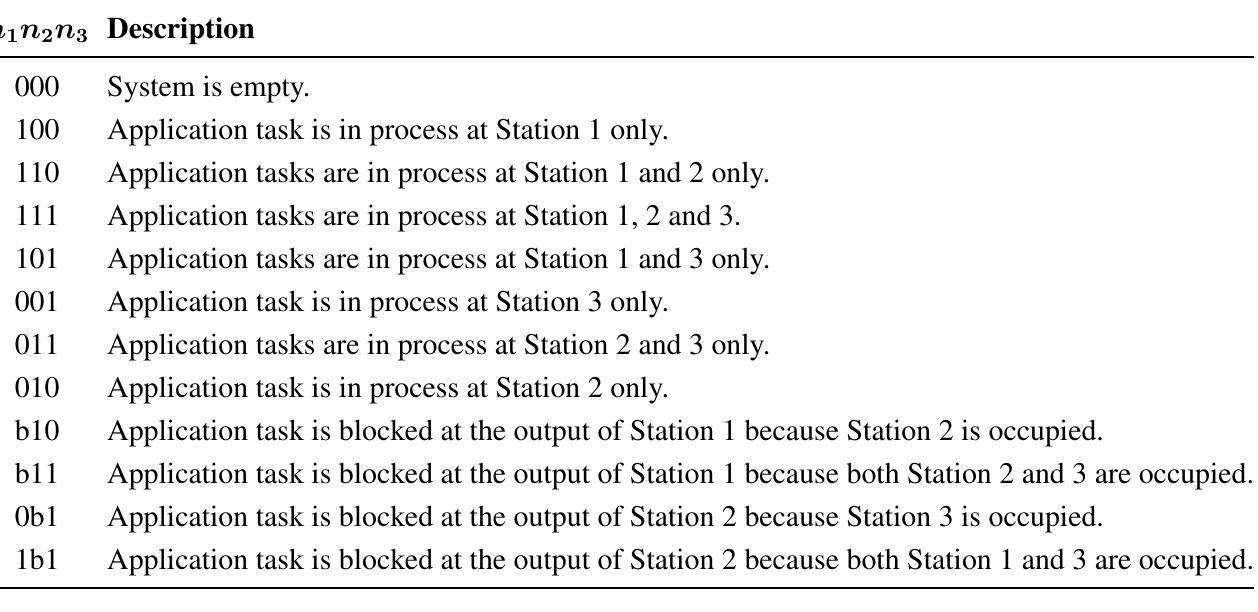
Table 1. Steady State Status during Tasks Processing.